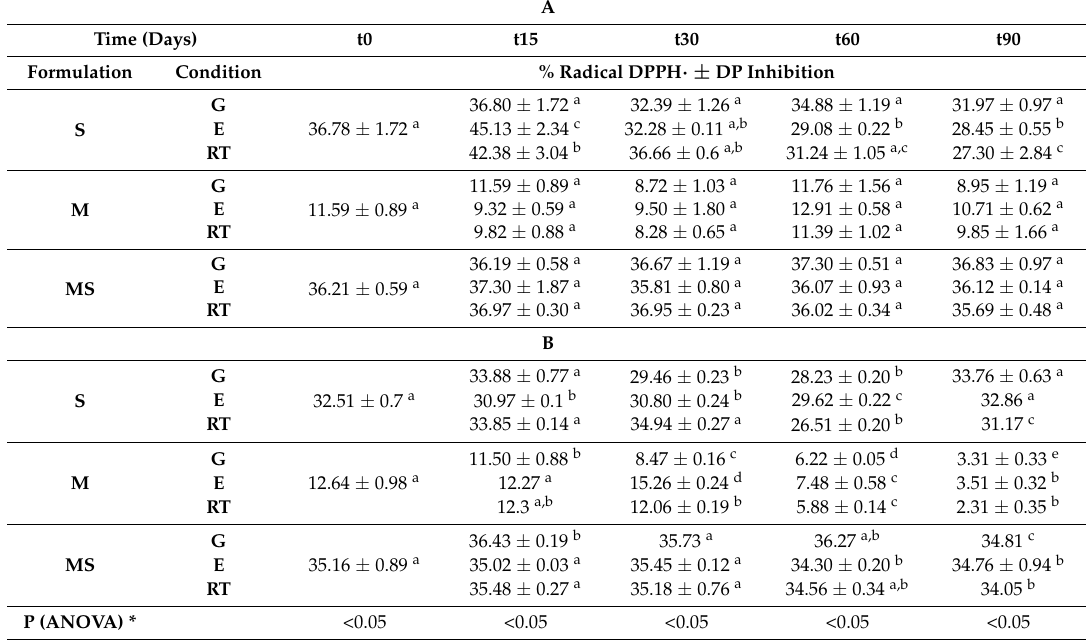
Table 2. Analysis of antiradical activity as assessed by Normal Stability Test of formulations developed with cream bases A and B with addition of chemical and physical filters ( M ), rutin succinate ( S ) or rutin succinate + chemical and physical filters ( MS